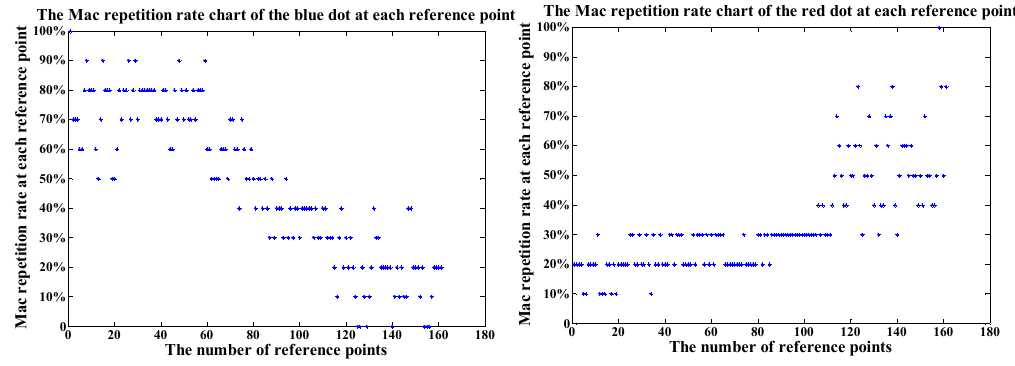
Figure 8. The distributions of MAC repetition rate of two test points on the same floor.